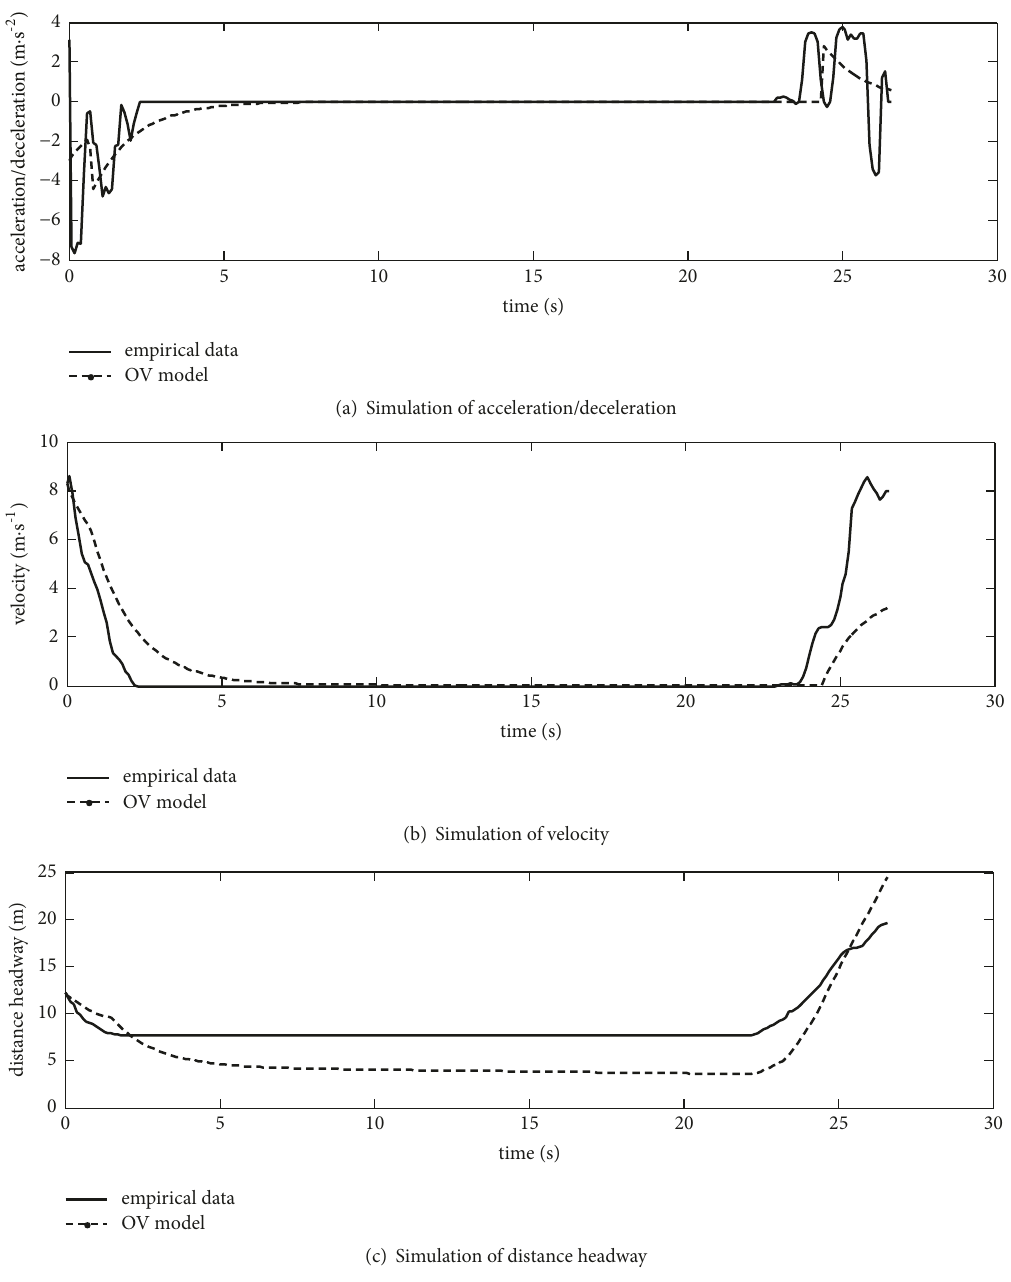
Figure 4: OV model simulations of car-following Process